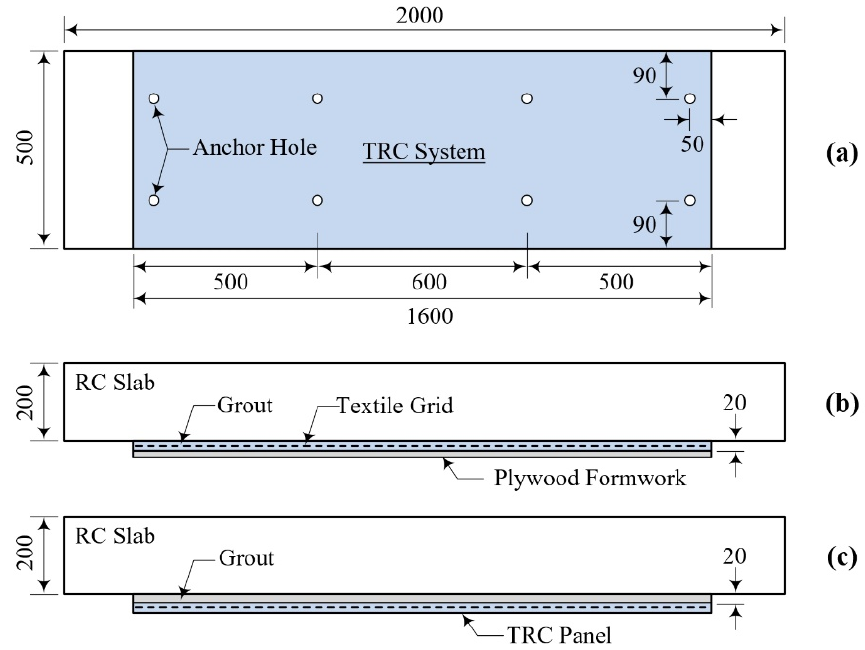
Figure 8. Repair plan for RC element with TRC grouting system: ( a ) repaired section; ( b ) CUW method; ( c ) PUW method (unit: mm).